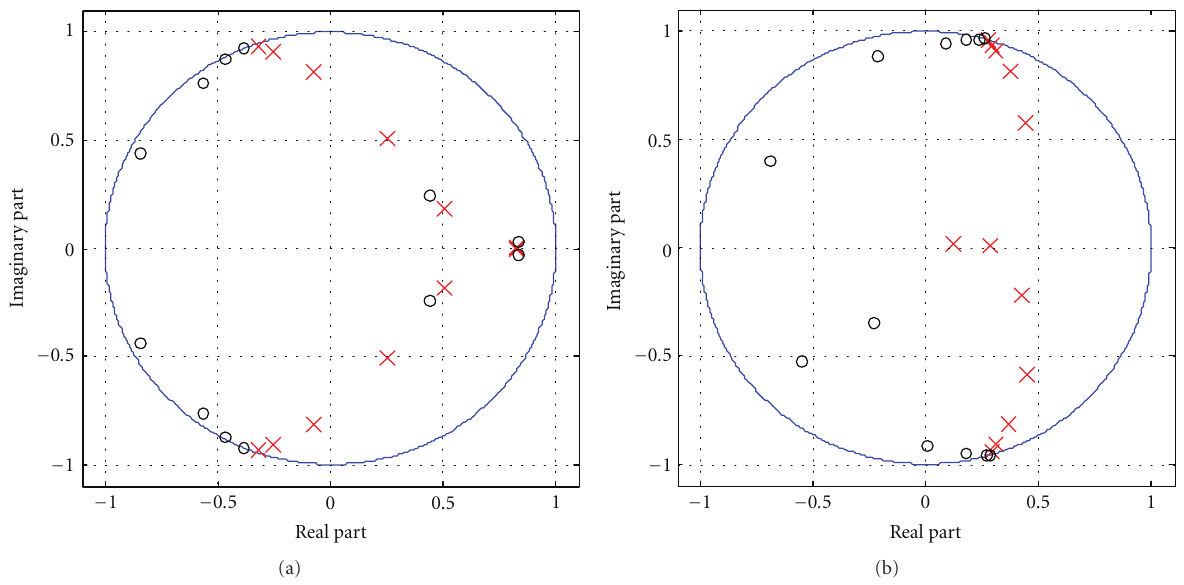
Figure 5: Positions of the poles and zeros in the unit circle for the designed filters.